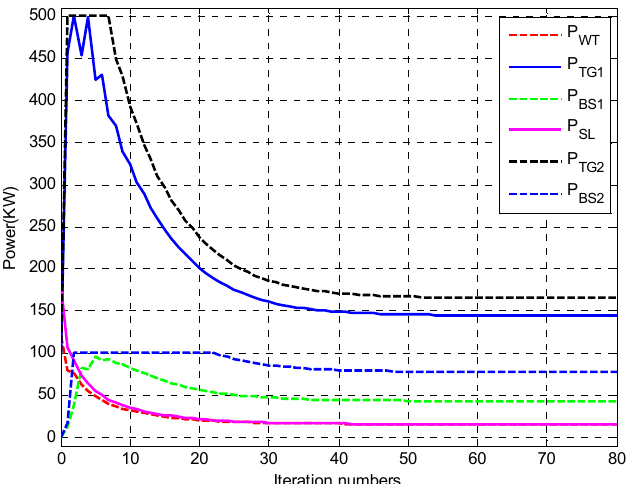
Figure 13. Power output of the proposed method with the same parameters.